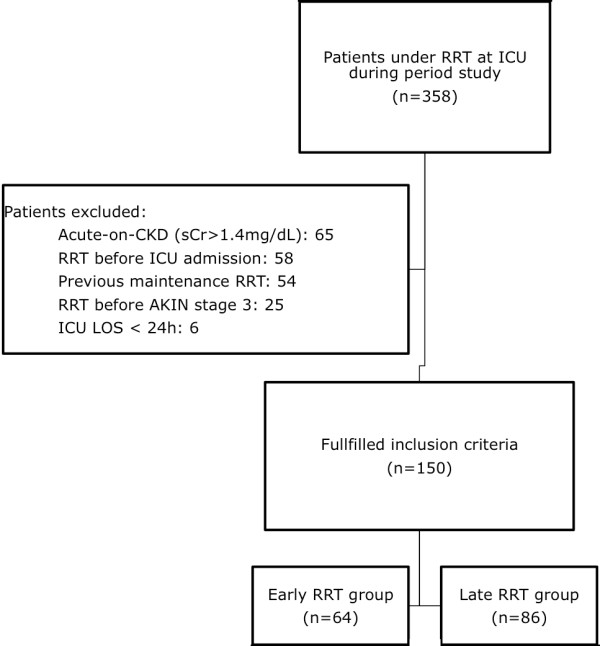
Patient identification and selection approach. RRT, renal replacement therapy; CKD, chronic kidney disease; AKIN, Acute Kidney Injury Network; LOS, length of stay.